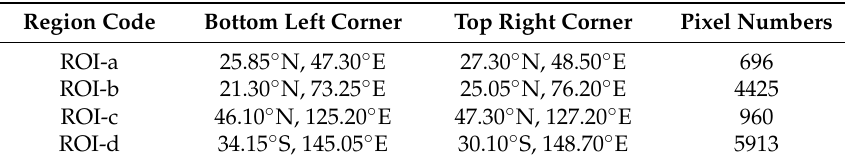
Table 2. Locations of four regions of interest (ROIs).